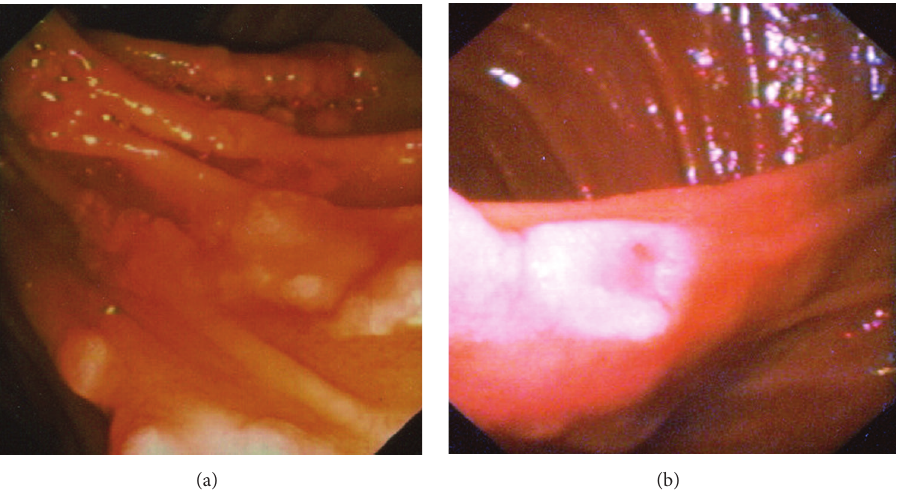
Figure 1: (a) Multiple (several dozen) irregular flat polyps in area of the descending duodenum, in locations other than the ampulla of Vater. (b) Multiple irregular flat polyps from 5mm to approximately 15mm in size, rather atypical in appearance with a central depression.